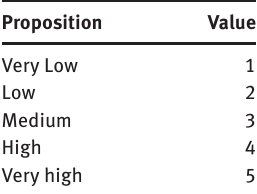
Table 2: Initial Values Attributed to